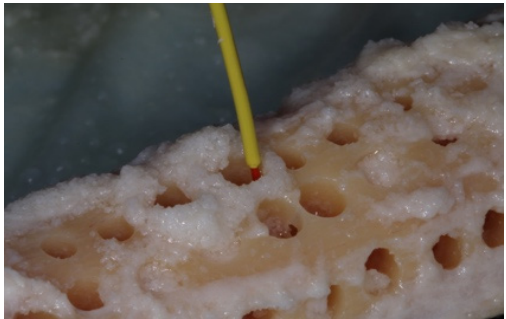
Figure 8. Immediately after osteotomy preparation to the 6 mm depth, the thermocouple probe was inserted along the osteotomy wall and floor and the highest temperature value was recorded ( Step 3 ).